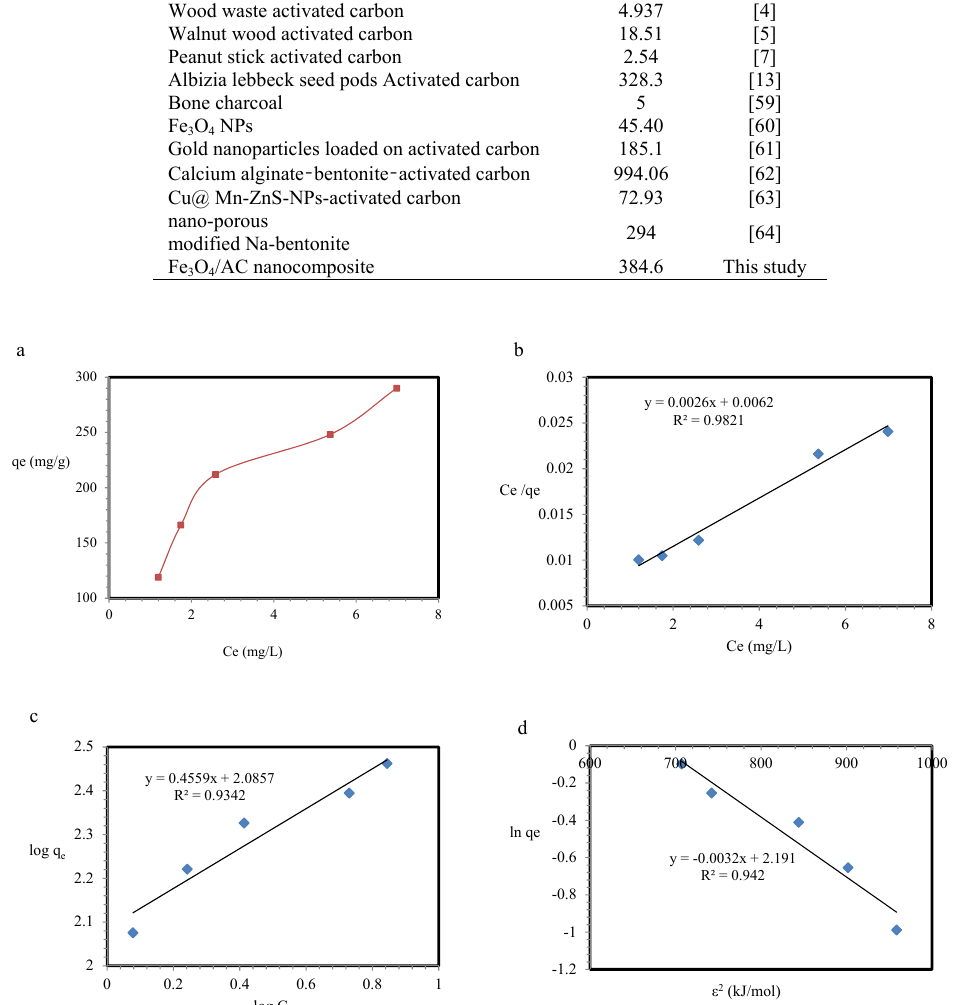
Fig. 7. (a) Effect of initial concentration on the removal of MB onto Fe O /AC nanocomposite (b) plot of Langmuir isotherm, (c) 3 4 plot of Freundlich isotherm, and (d) plot of Dubinin-Radushkevich isotherm. Fig. 7(a) Effect of initial concentration on the removal of MB onto Fe3O4/AC nanocomposite (b) plot of Langmuir isotherm, (c) plot of Freundlich isotherm, and (d) plot of Dubinin-Radushkevich